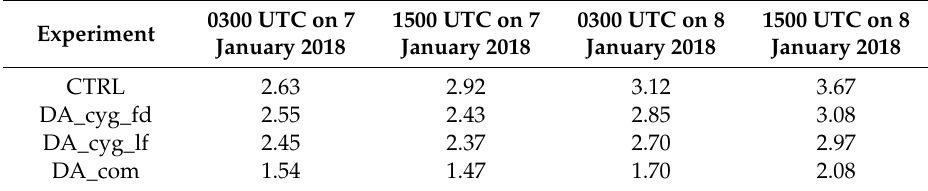
Table 2. Domain averaged RMS di ff erence of surface wind speed between ASCAT observation and di ff erent numerical experiments.